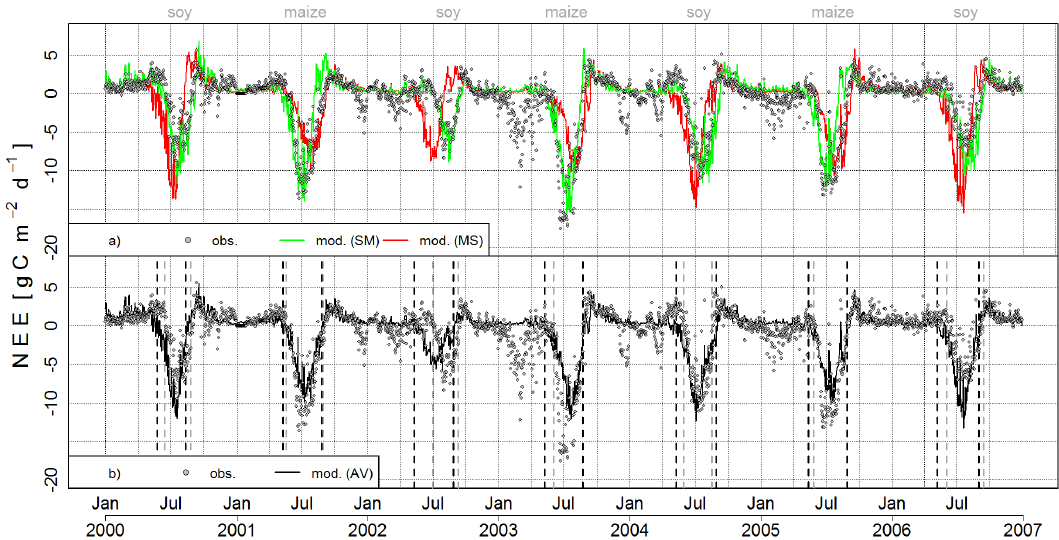
Fig. 7. Study area averages of modelled NEE fluxes (lines) and as observed at Bondville EC site (grey circles). Model data shown are (a) crop rotations with soybean sown in even years (green line, soybean–maize (SM), as Bondville site rotation), soybean sown in odd years (red line, MS), and (b) means over all 104 MODIS pixel locations (black line, average (AV), i.e. not crop type specific). Vertical dashed lines in (b) denote SoS and EoS dates as estimated from model data (black) and observations (grey).